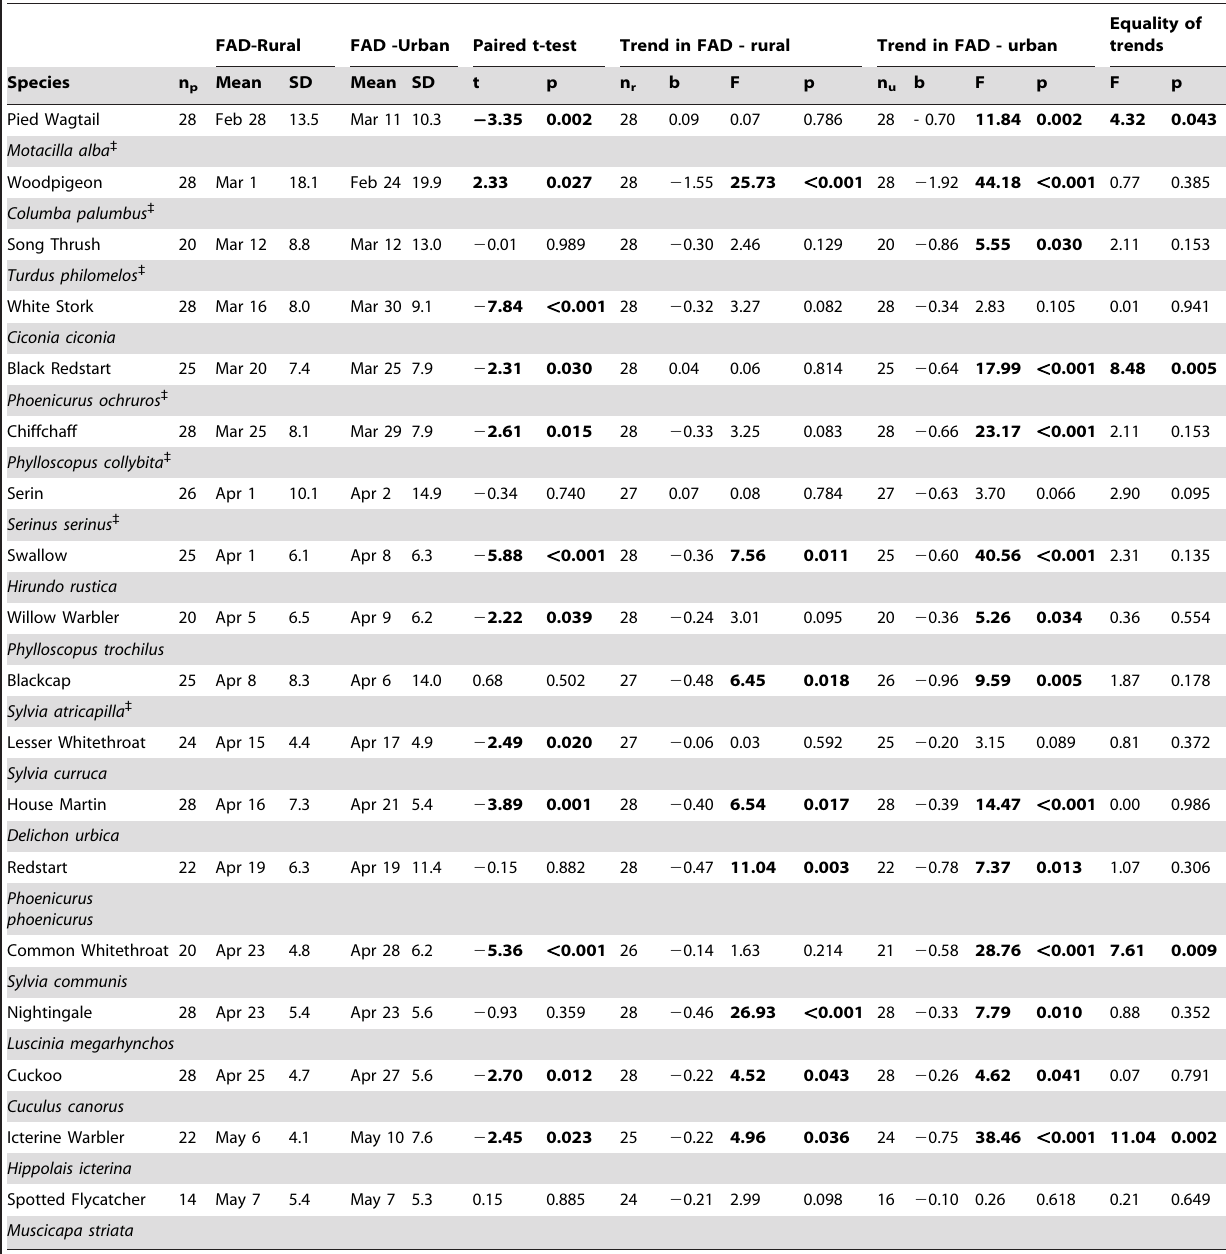
Table 1. Basic phenological data and trends on analysed bird species.